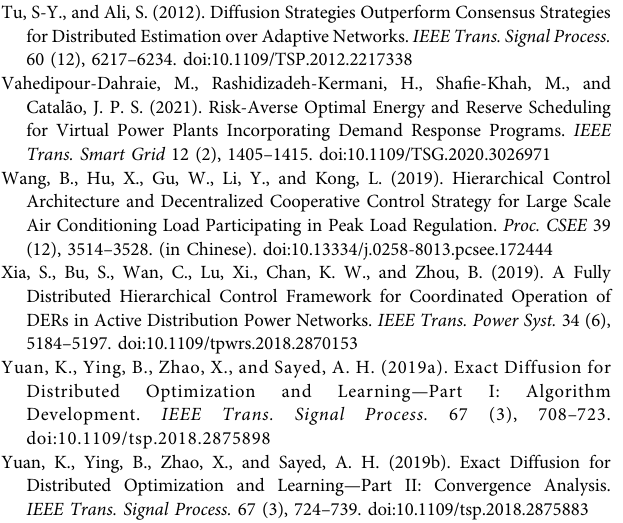
Development. IEEE Trans. Signal Process. 67 (3), 708 –